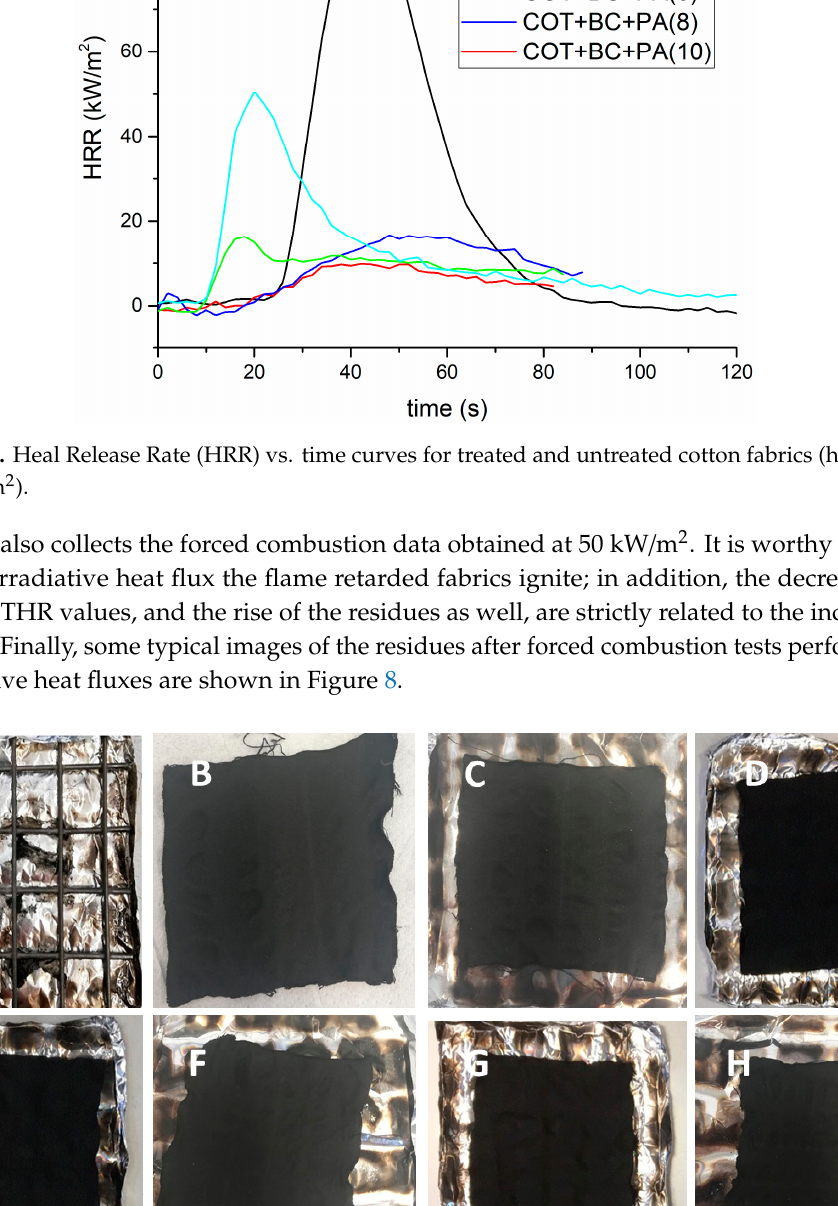
Table 4. Forced ‐ combustion data for untreated and treated cotton fabrics.